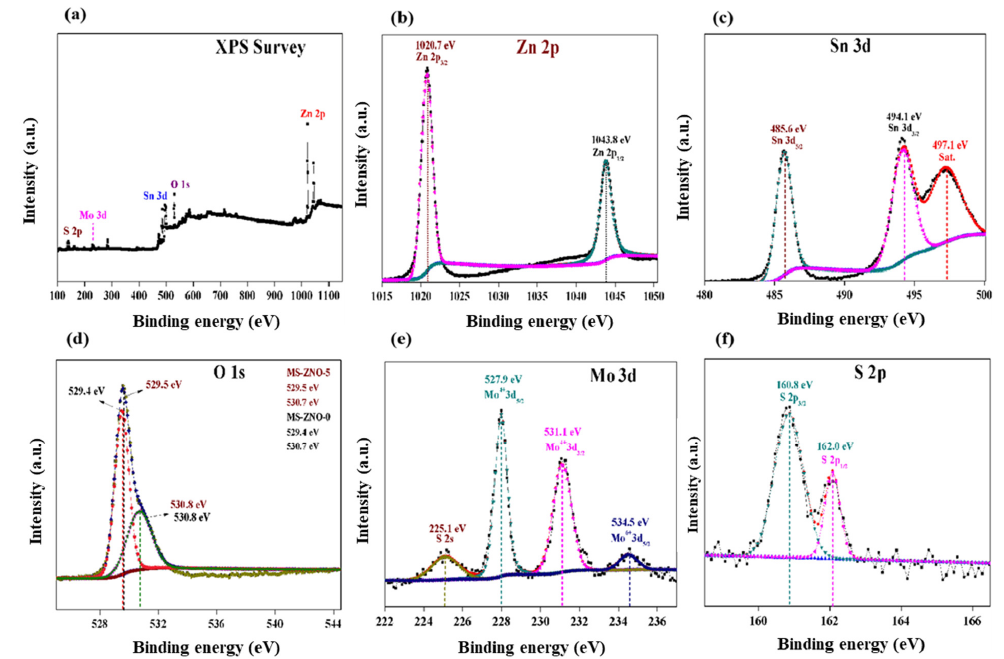
Figure 4. ( a ) XPS survey of MS-ZNO-5; ( b , c ) Zn 2p and Sn 3d spectrum(cid:31)s of MS-ZNO-5; ( d ) O 1s spectrum of MS-ZNO-5 and MS-ZNO-0; ( e , f ) Mo 3d and S 2p spectrum(cid:31)s of MS-ZNO-5. spectrum of MS-ZNO-5 and MS-ZNO-0; ( e , f ) Mo 3d and S 2p spectrum’s of